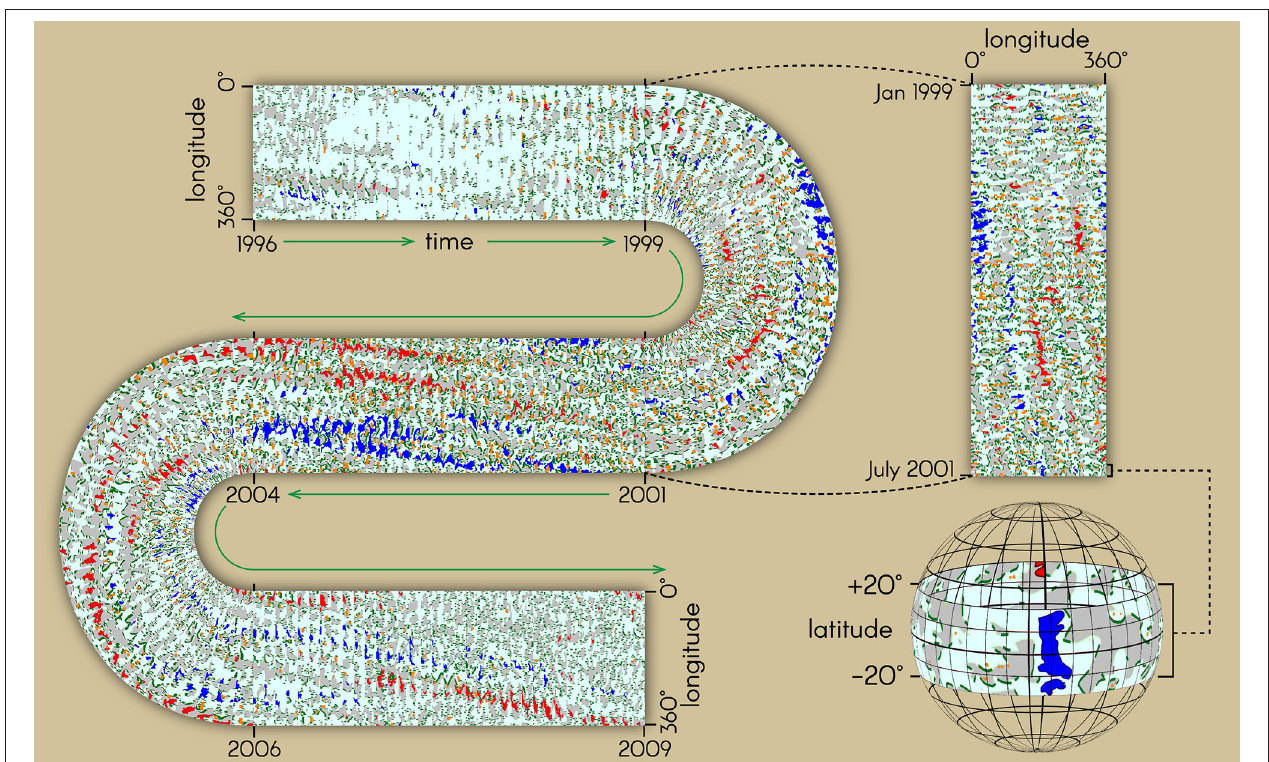
FIGURE 9 | A sequence of equatorial slices ( − 20 ◦ to + 20 ◦ latitude) is stacked along a curving axis, like a snake, advancing in time through CRs 1910-2084 (SC 23); width is longitude (after, e.g., McIntosh and Wilson, 1985). Colors are as in Figure 1 (bottom). The panels on the right show how an equatorial latitude strip from one CR is patched into a stackplot which in turn becomes a curvilinear part of the entire “snake” that traverses all of SC 23.